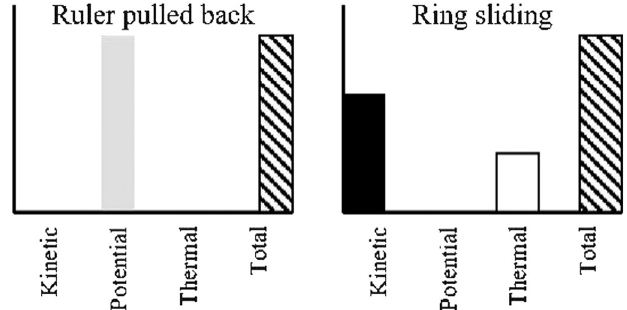
dissipation.FIG. 2. Energy bar charts for ring slider scenario. While the ruler is pulled back (before it smacks the ring), all of the energy is potential energy. While the ring is sliding, the energy is partly kinetic (the ring is moving) and partly thermal (the ring and floor warm as they rub